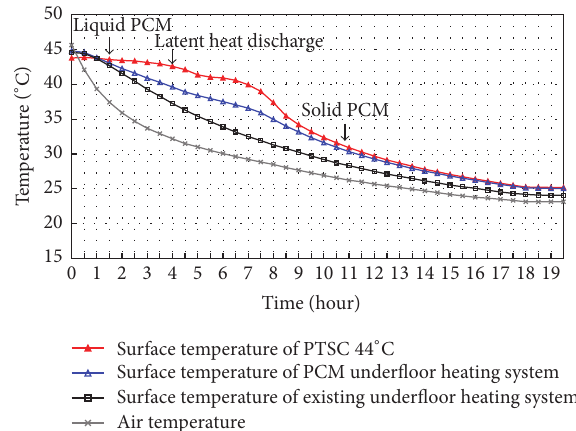
Figure 10: Surface temperatures of existing underfloor heating system and PUFHS with PTSC 44 ∘